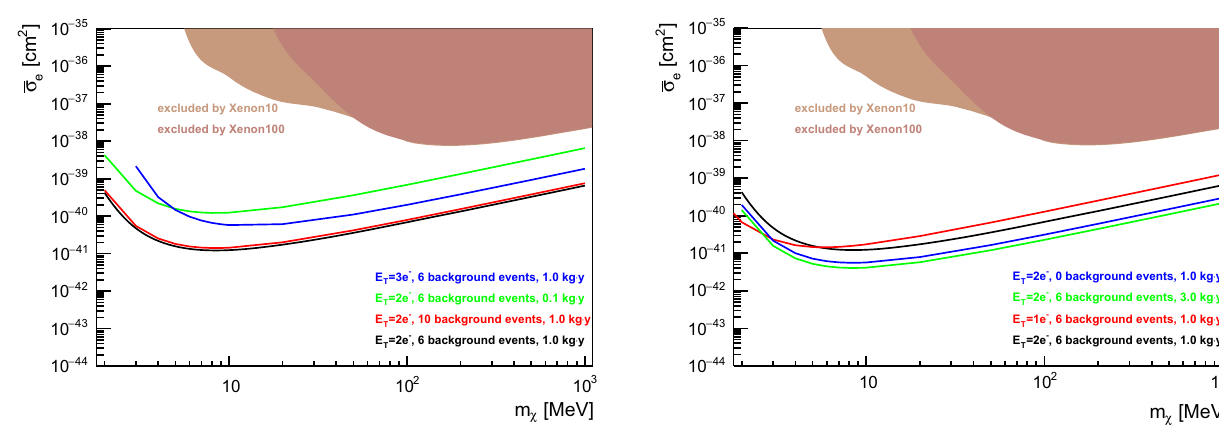
Fig. 12 Expectedsensitivityfordarkmatter-electronscatteringassum- ing a threshold of Q = 2 e − , six background events and an exposure of 1kgyear(blackline).Inadditionweshowthesensitivitywithareduced threshold of Q = 1 e − (red), increased exposure of 3kg year (green) and decreased background of zero events (blue). We assume a constant form factor of F DM ( q ) = 1. For comparison the best limit using data from Xenon10 and Xenon100 is shown